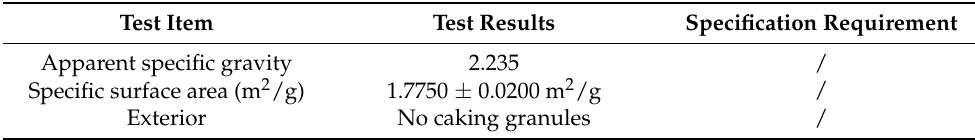
Table 10. Physical properties of the brake pad